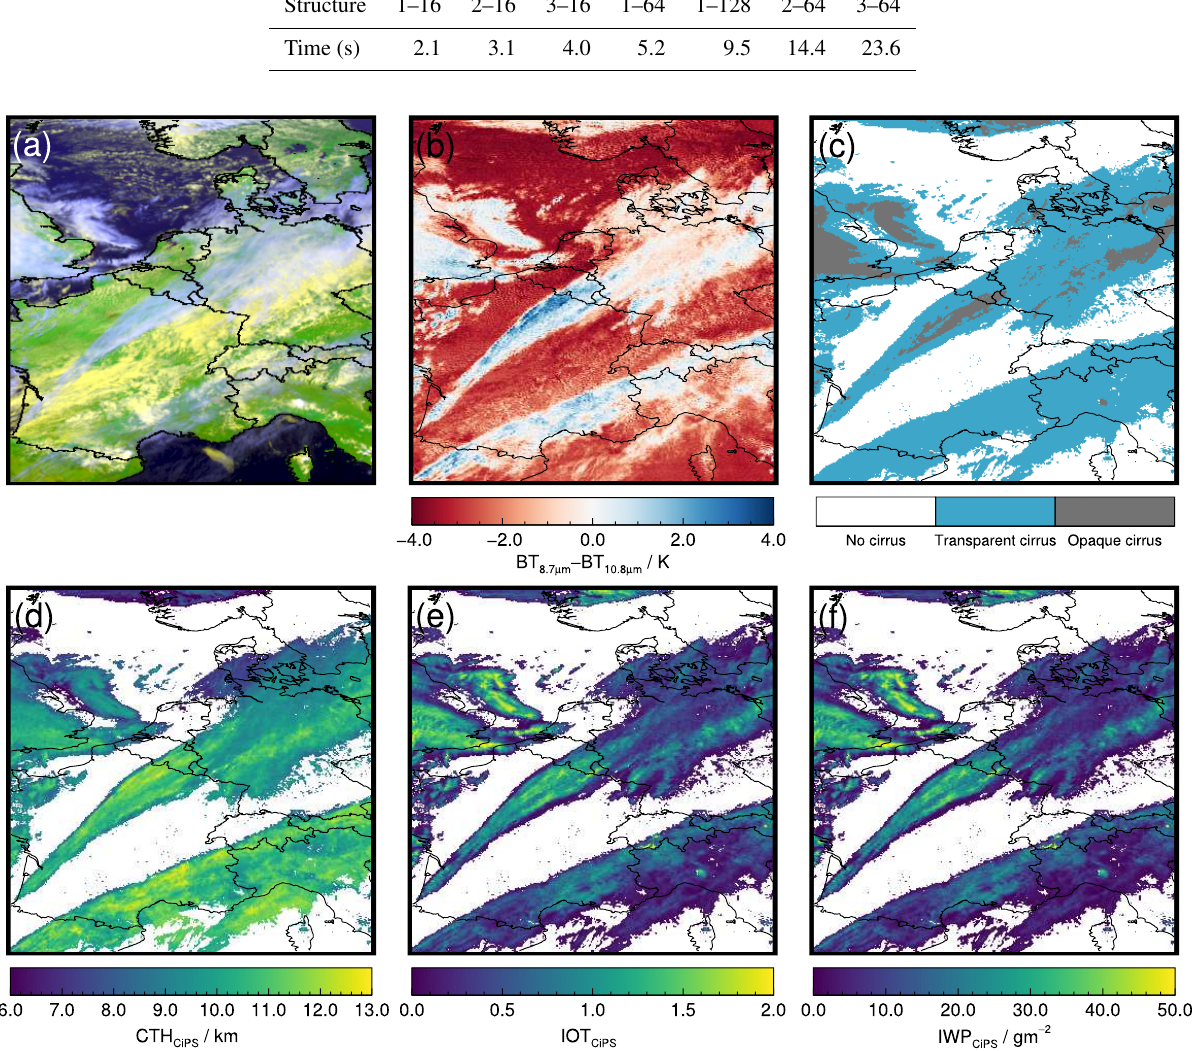
Figure 5. (a) MSG-3/SEVIRI false colour RGB composite over parts of Europe on 1 June 2015 at 12:30UTC, the corresponding (b) bright- ness temperature difference BT 8 . 7µm − BT 10 . 8µm and the (c) cirrus cloud mask with opacity information, (d) CTH, (e) IOT and (f) IWP retrieved by